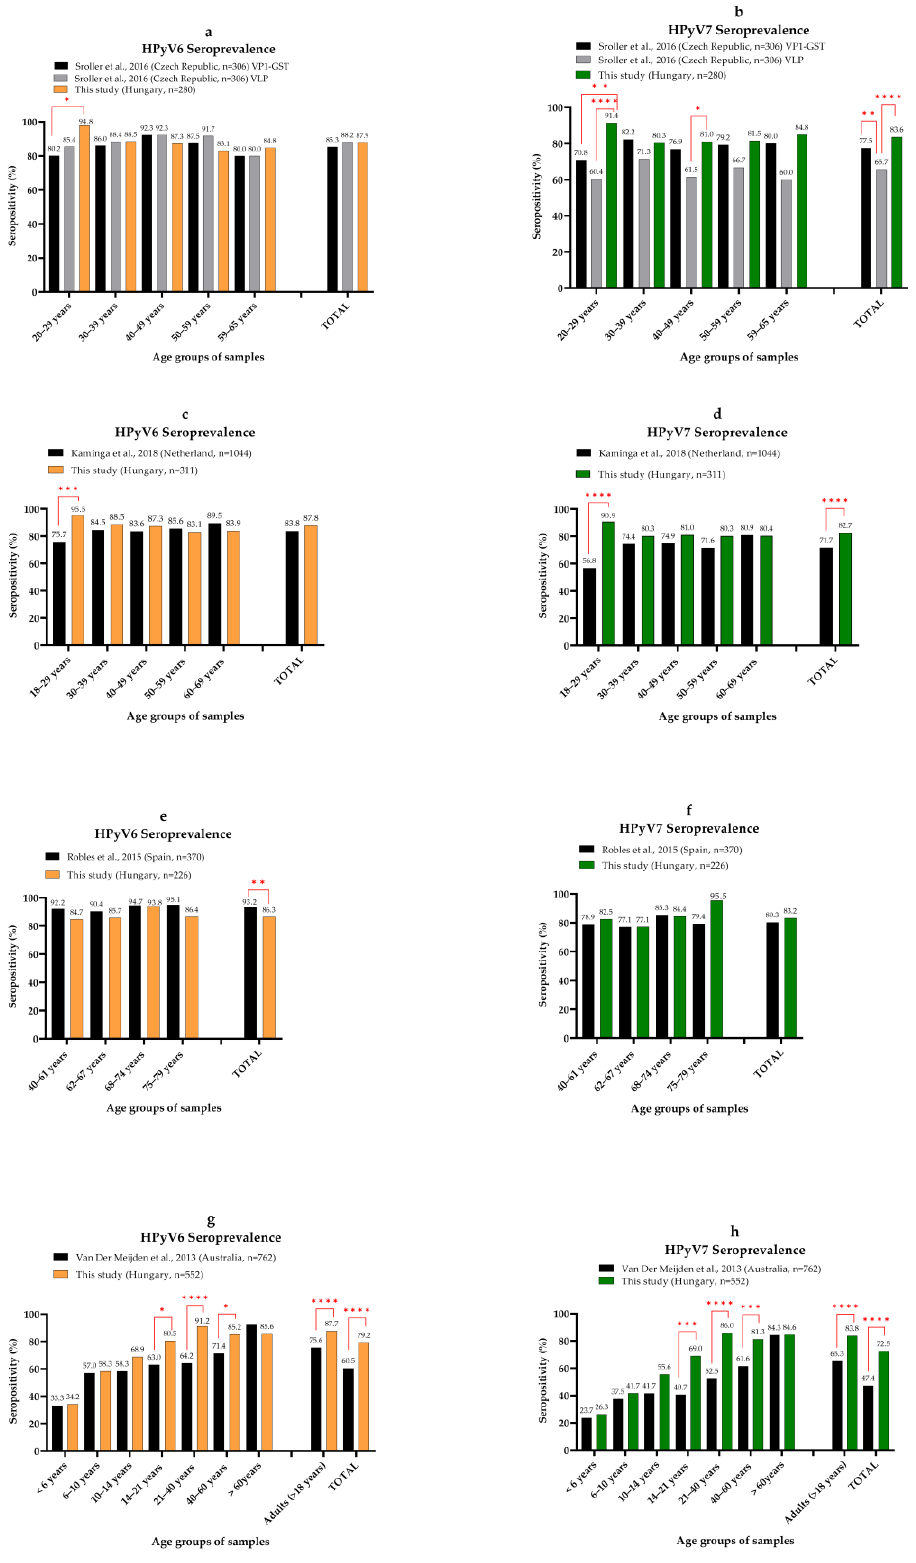
Figure 6. Pairwise comparison of age-specific HPyV6 and HPyV7 seroprevalence. Each panel represents a comparison between our results and one published study which are the the followings: ( a , b ) [36], ( c , d ) [38], ( e , f ) [40] and ( g , h ) [35]. Significant differences between age groups are indicated by red lines and asterisks (Fisher’s exact test, * p ≤ 0.05, ** p ≤ 0.01, *** p ≤ 0.001, **** p ≤